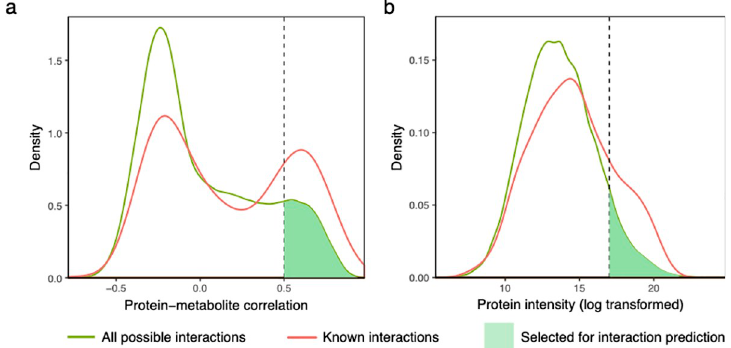
Fig 3. Distribution of correlations and intensities for protein–metabolite interactions. (a) The distribution of protein − metabolite correlations is bimodal, with known interactions showing increased correlations. We chose a cutoff of 0.5 for interaction predictions. (b) Proteins of higher intensity (i.e. abundance) are enriched among the known interactions. In both panels, the difference between the distributions is highly significant (p � 2e-15 using Mann-Whitney U test).